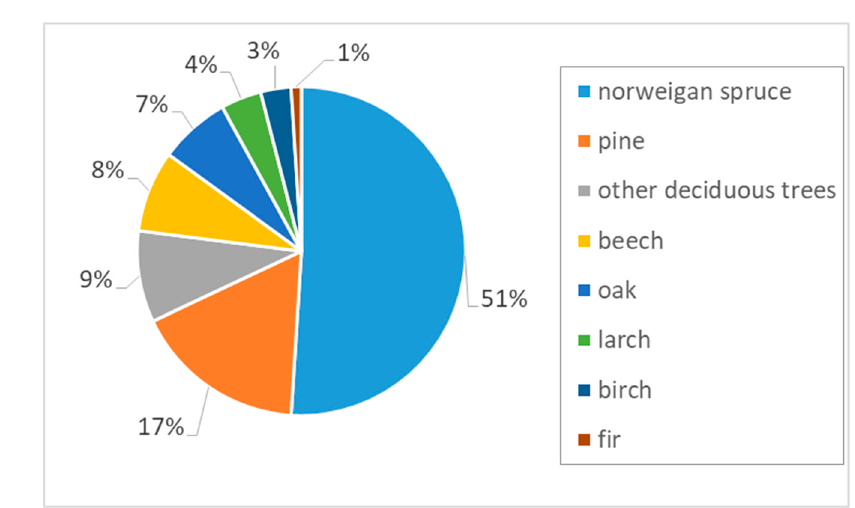
Figure 1. Area of interest.